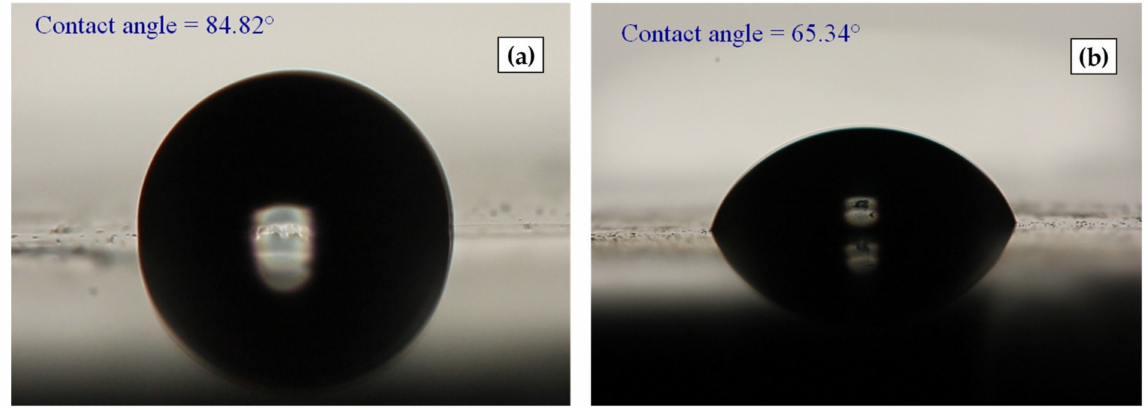
Figure 9. Photos of sessile drops (5 µ L) in contact with a solid surface: ( a ) water drop on the bitumen; ( b ) ethylene glycol on the bitumen 70/100.